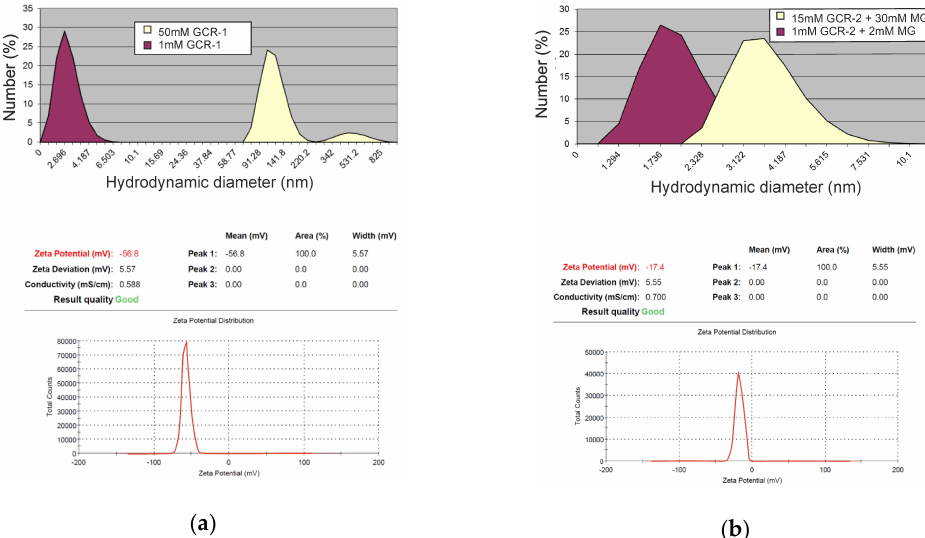
Figure 4. Particle size distribution and zeta-potential value of GCR solutions: ( a ) water solution of 1 mM and 50 mM GCR-1; ( b ) water solution of 1 and 15 mM GCR-2 in the presence of two-fold excess MG.